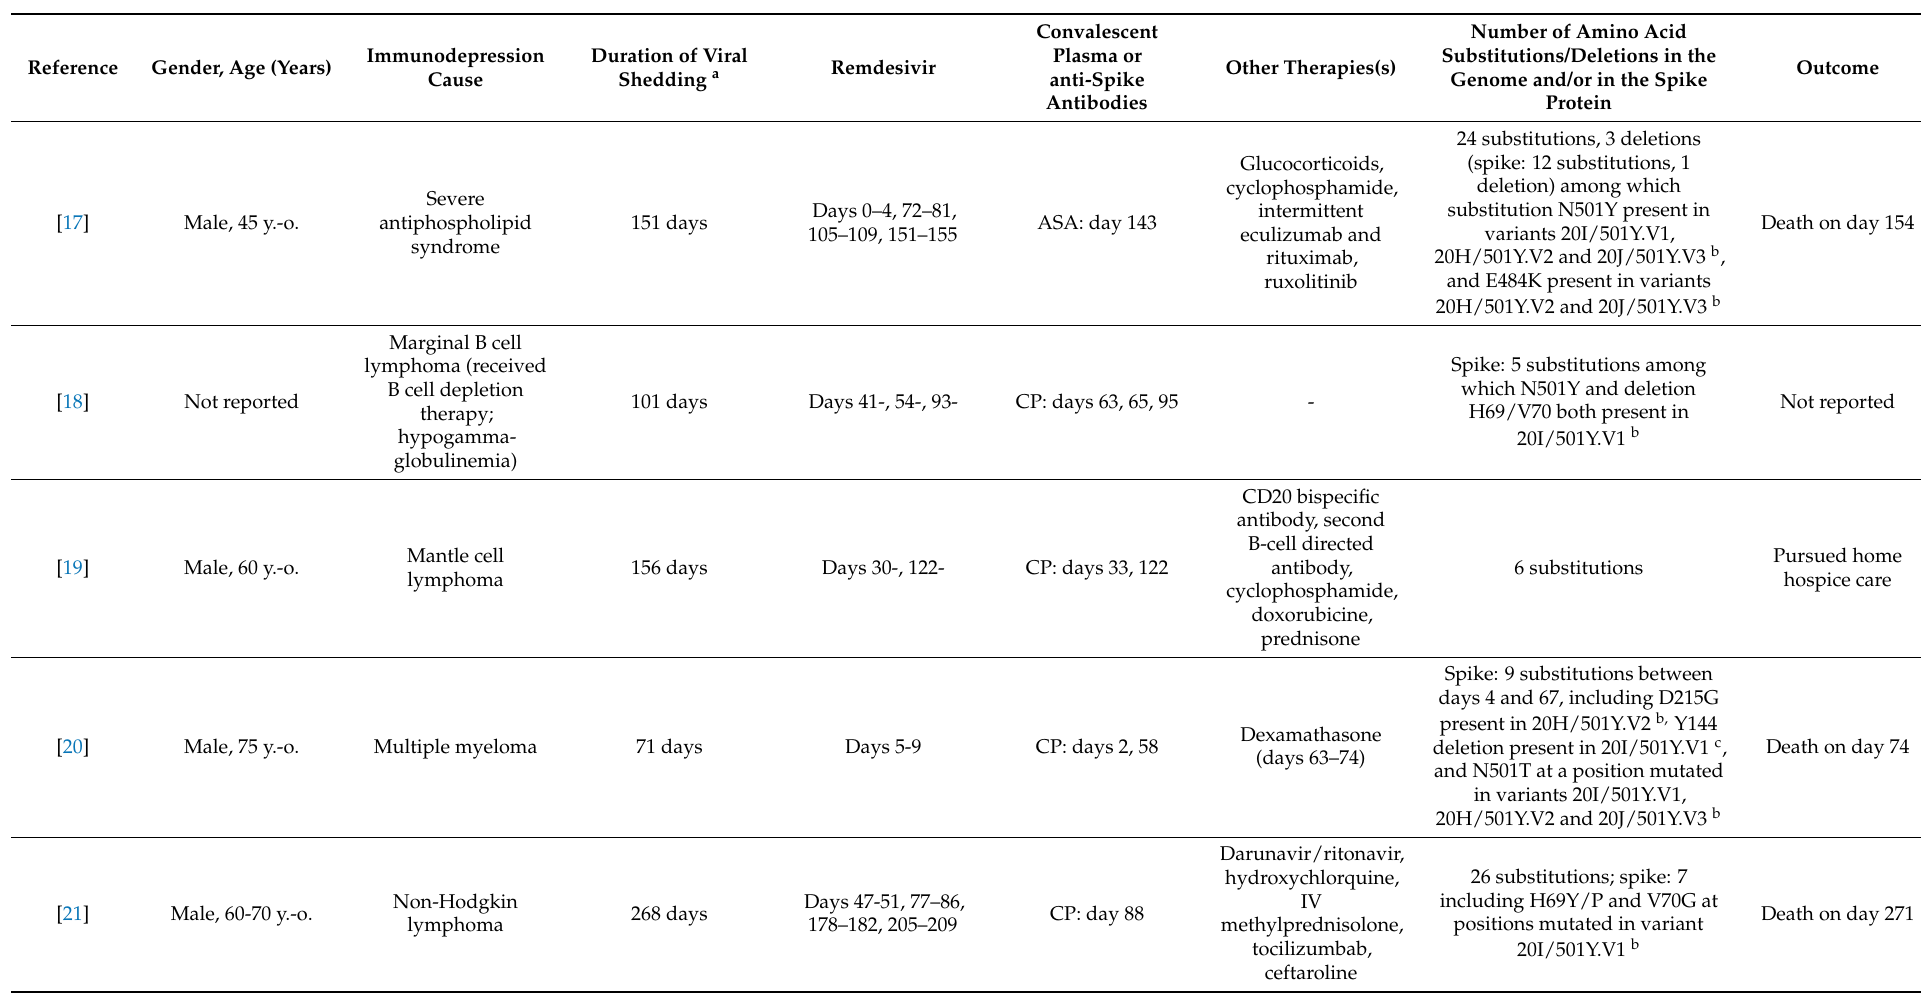
Table 4. Epidemiological, virological and clinical features of cases of prolonged SARS-CoV-2 infections in immunocompromised